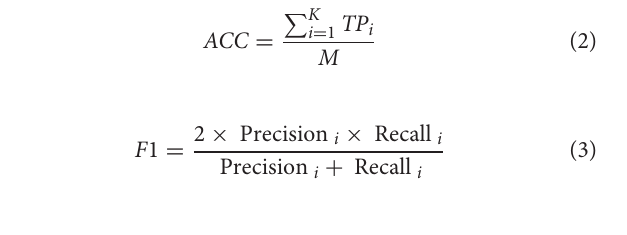
features, and d is the length of x i ,1 ≤ i ≤ N . The corresponding